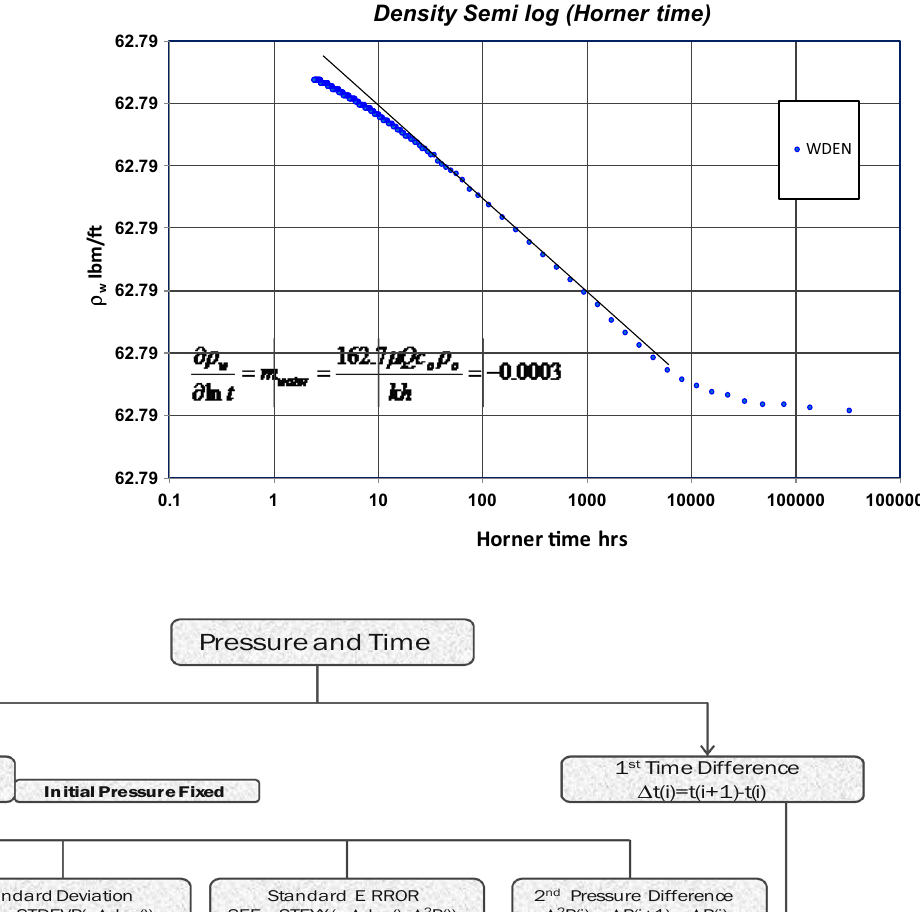
Fig. 16 Specialised semi-log